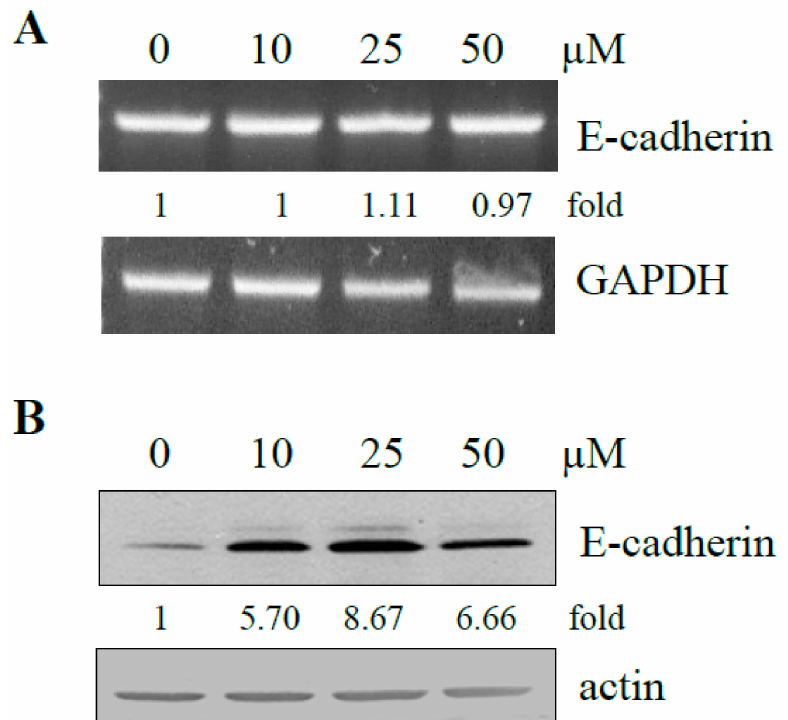
Figure 6. E ff ect of treatment by increasing dose of resveratrol on E-cadherin mRNA and protein expression. ( A ) DU145 was treated with 10, 25, and 50 µ M resveratrol for two days. Changes in mRNA of E-cadherin were assayed by RT-PCR and quantified and expressed as a fold di ff erence against GAPDH. ( B ) Changes on E-cadherin protein expression by resveratrol were analyzed by Western blot analysis. Intensity of specific bands from control and treated cells in panel B was each normalized to actin and expressed as fold of